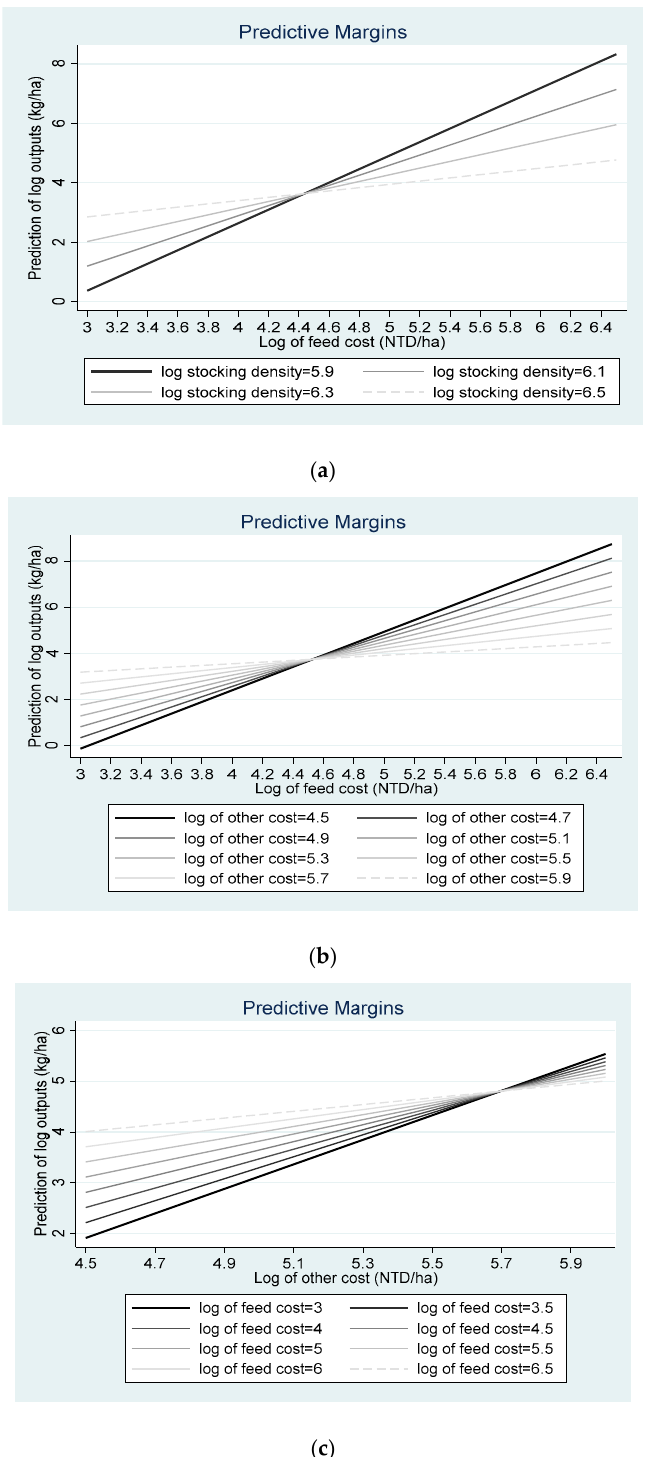
Figure 4. The interaction effect of stocking density, feed cost, and other cost on simulated hard calm productions with control variables in a higher stocking density (HSD) regression regime. ( a ) Interaction of feed cost and stocking density on prediction of outputs. ( b ) Interaction of feed cost and other cost on prediction of outputs. ( c ) Interaction of other cost and feed cost on the prediction of outputs.